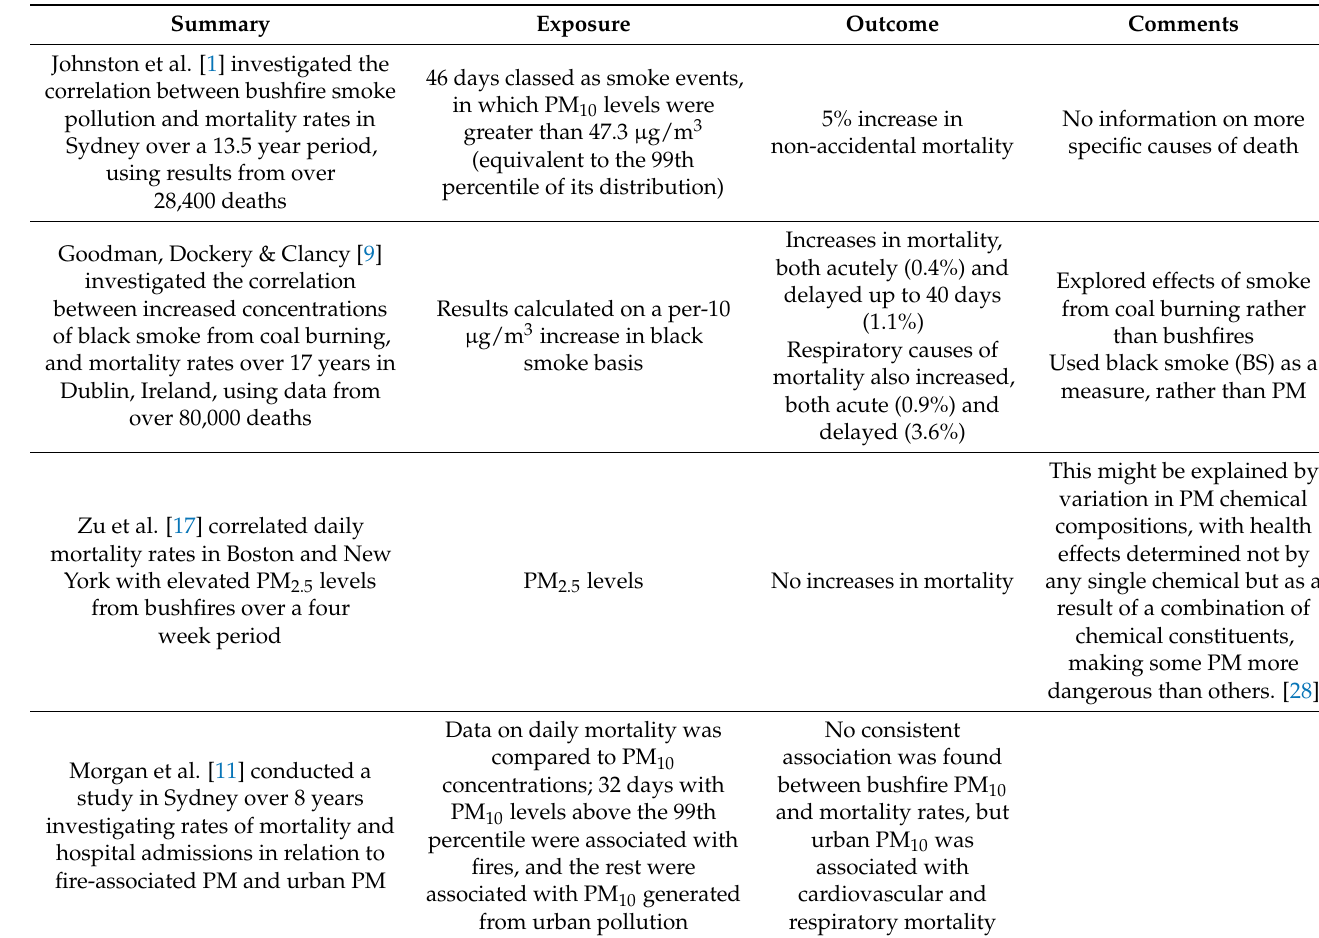
Table 2. Summary of studies investigating PM and human mortality using search terms “Cattle smoke mortality” or “Bushfire smoke particulate matter PM” in Google